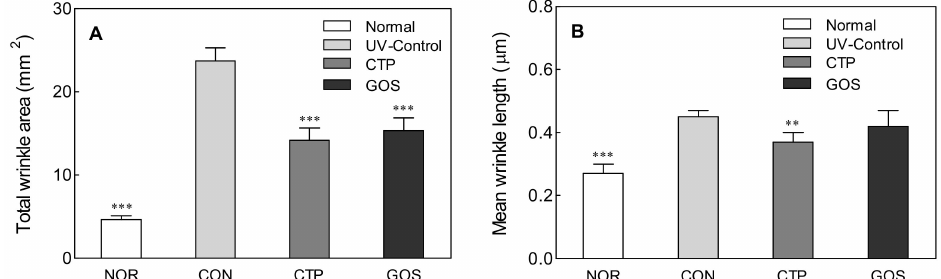
Figure 2. E ff ect of galacto-oligosaccharide (GOS) intake on total wrinkle area ( A ) and mean wrinkle length ( B ) in ultraviolet (UV) B-irradiated hairless mice. Data are expressed as mean ± standard deviation, and di ff erent symbols indicate significant di ff erences at ** p < 0.01 and *** p < 0.001 vs. CON group. Normal (NOR; unirradiated mice); ultraviolet (UV) B control (CON; irradiated and untreated mice); CTP intake at 200 mg / kg (CTP; irradiated and CTP-treated mice); GOS intake at 200 mg / kg (GOS; irradiated and GOS-treated